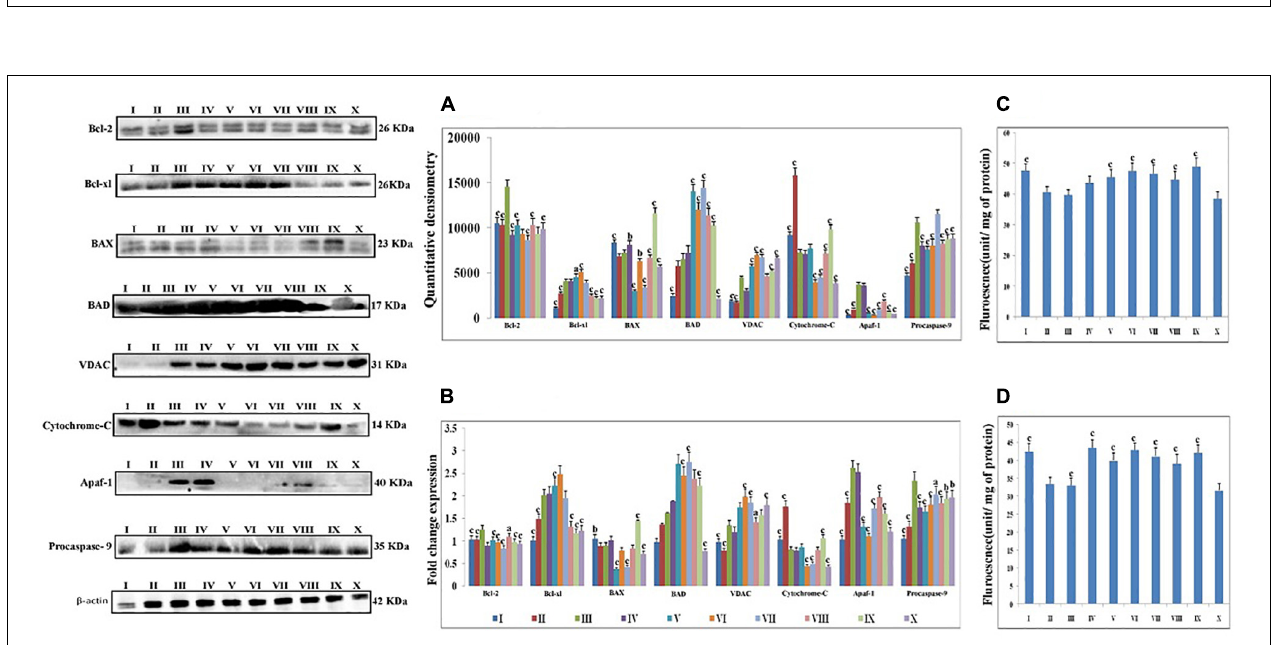
FIGURE 3 | Effect of taVNS on mitochondrial apoptosis. The details of the groups for western blot analysis and caspase assay are as follows: I-Control, II-taVNS control, III-DMH control, IV-taVNS1, V-taVNS 2, VI-taVNS 3, VII-taVNS 4, VIII-taVNS 5, IX-Standard chemotherapy, X-Dummy control. Specific treatments for particular groups mentioned in Supplementary Table 1 . (A) Proteins were extracted from individual groups and subjected to immunoblotting of pro-apoptotic (BAX and BAD) and anti-apoptotic (Bcl-2 and Bcl-xl) markers along with downstream markers of apoptotic pathway (VDAC, cytochrome-c, Apaf-1, and procaspase 9). After treatment with DMH the anti-apoptotic proteins (Bcl-2 and Bcl-xl) expression was increased. The expression of pro-apoptotic protein BAX decreased while BAD increased. The taVNS treatment results in restoration of anti-apoptotic and pro-apoptotic proteins with exception of BAD. When observed, the expression of markers of mitochondrial apoptosis (VDAC, cytochrome c, Apaf-1, and procaspase 9) treatment with DMH results in increased expression of VDAC, Apaf-1, and procaspase 9 along with decreased expression of cytochrome c. Treatment with taVNS resulted in increased expression of cytochrome c and decreased expression of procaspase 9. (B) The outcomes from the immunoblotting assay were confirmed through qRT-PCR studies by scrutinizing the respective phenotypes of pathway associated proteins. The mRNA expressions of the above mentioned protein were also in line with the findings of immunoblotting assay. β -actin was used as loading control in immunoblotting and qRT-PCR assay. (C,D) Represent the levels of caspase 3 and 8, respectively. The activity of caspase was detected by commercial fluorescence based assay. The caspase 3 and caspase 8 levels were decreased after DMH treatment and taVNS (particular taVNS 3) up-regulated the same. Each experiment was performed in triplicate. Values are presented as mean ± SD. Comparisons were made by the one-way ANOVA followed by Bonferroni multiple test. All groups were compared to the DMH treated group ( a p < 0.05, b p < 0.01, c p < 0.001).